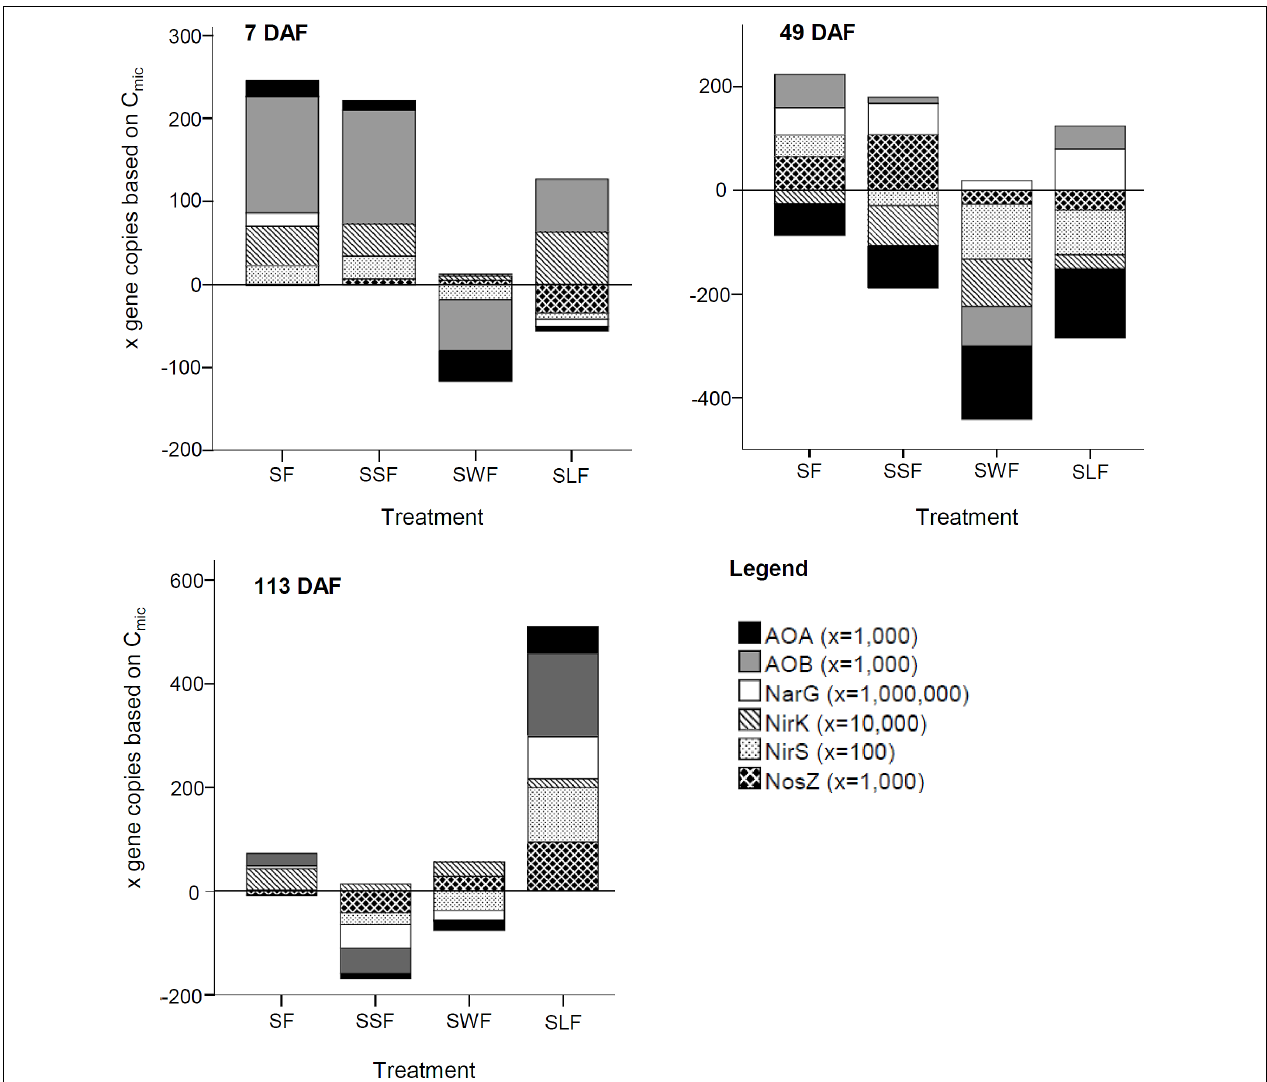
FIGURE 3 | Influence of HCA on the abundance of the ammonia oxidizing bacteria (AOB) and archaea (AOA), as well as of various denitrifiers (NarG, nirK, nirS, and NosZ) at 7, 49, and 113 days after mineral N fertilization (DAF) in soil with only mineral N fertilizer (SF), with N fertilizer plus lignin (SLF), spruce sawdust (SSF), or wheat straw (SWF) relative to the control treatment S ( y = 0) without any N fertilization or HCA application. Gene copies per gram soil were normalized to C mic (gene copies per µ g C mic ). Multiplication factors of gene copies per µ g C mic are available in the according brackets next to the gene symbol and name. Statistical significances are described in the Section “HCA-Induced Changes in the Soil Microbiome” of the